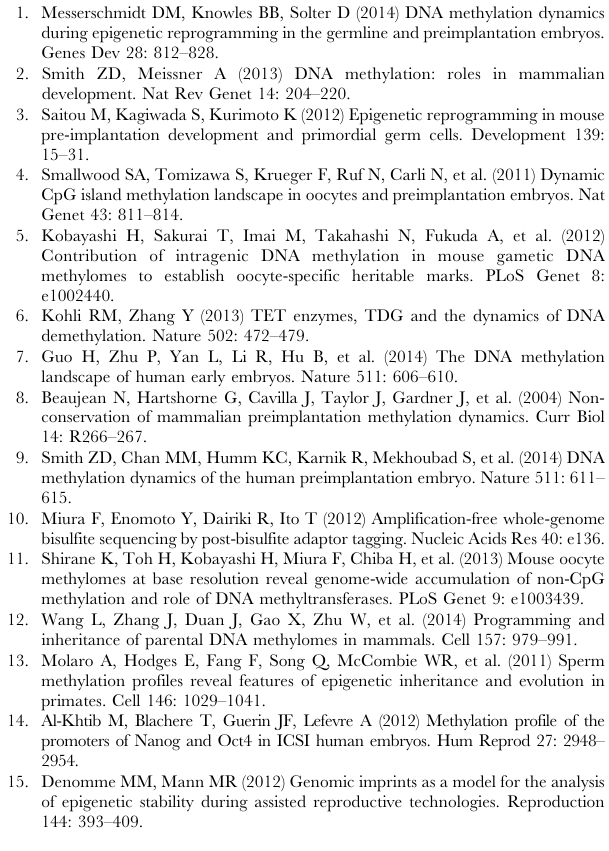
S2 Table Gene body methylation and transcription levels in human and mouse oocytes. Only genes longer than 5 kb were analyzed. Homologous genes between the human and mouse are shown with HomoloGene IDs. (XLSX) S3 Table DNA methylation levels of repeat sequences. We analyzed SINEs, LINEs, LTRs, DNA repeats, SVAs and satellites with . 100 copies in the human genome. Mean methylation levels of CpGs are shown. (XLSX) S4 Table Proportion of repeat copies highly methylated in human blastocysts. We analyzed SINEs, LINEs, LTRs, DNA repeats, SVAs and satellites with . 100 copies in the human genome. Proportions of repeat copies overlapping . 70% methyl- ated windows are indicated.